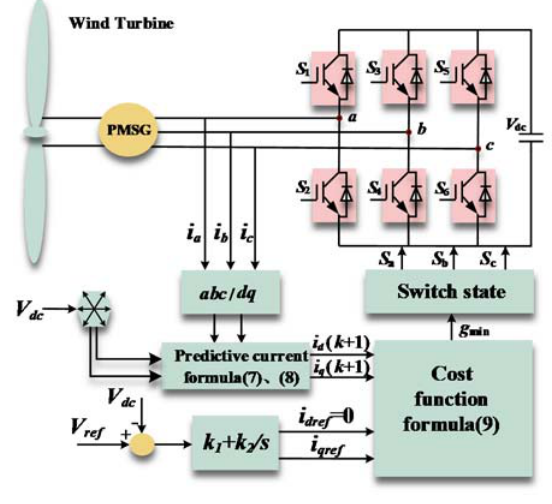
Figure 2. Generator ‐ side converter control block diagram. Figure 2. Generator-side converter control block